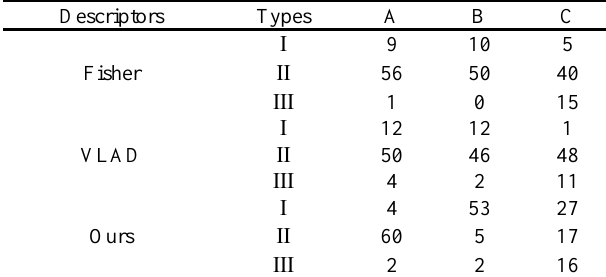
Table 1 Global descriptor experimental results